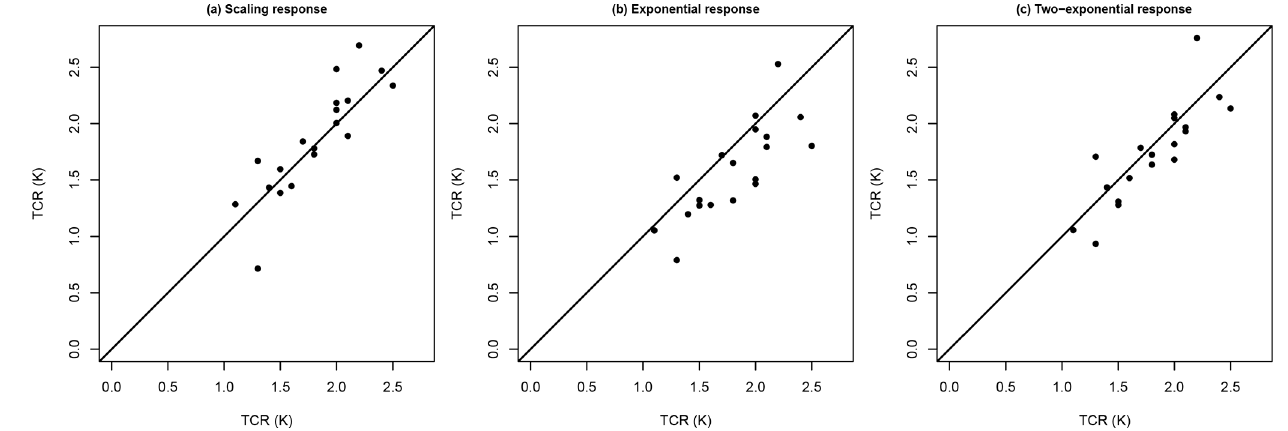
Figure 8. Scatter plot of the TCR obtained directly from the 19 ESMs against the corresponding marginal posterior mean estimates when using a scale-invariant response function (a) , a single-exponential response function (b) , and a two-exponential response function (c) .